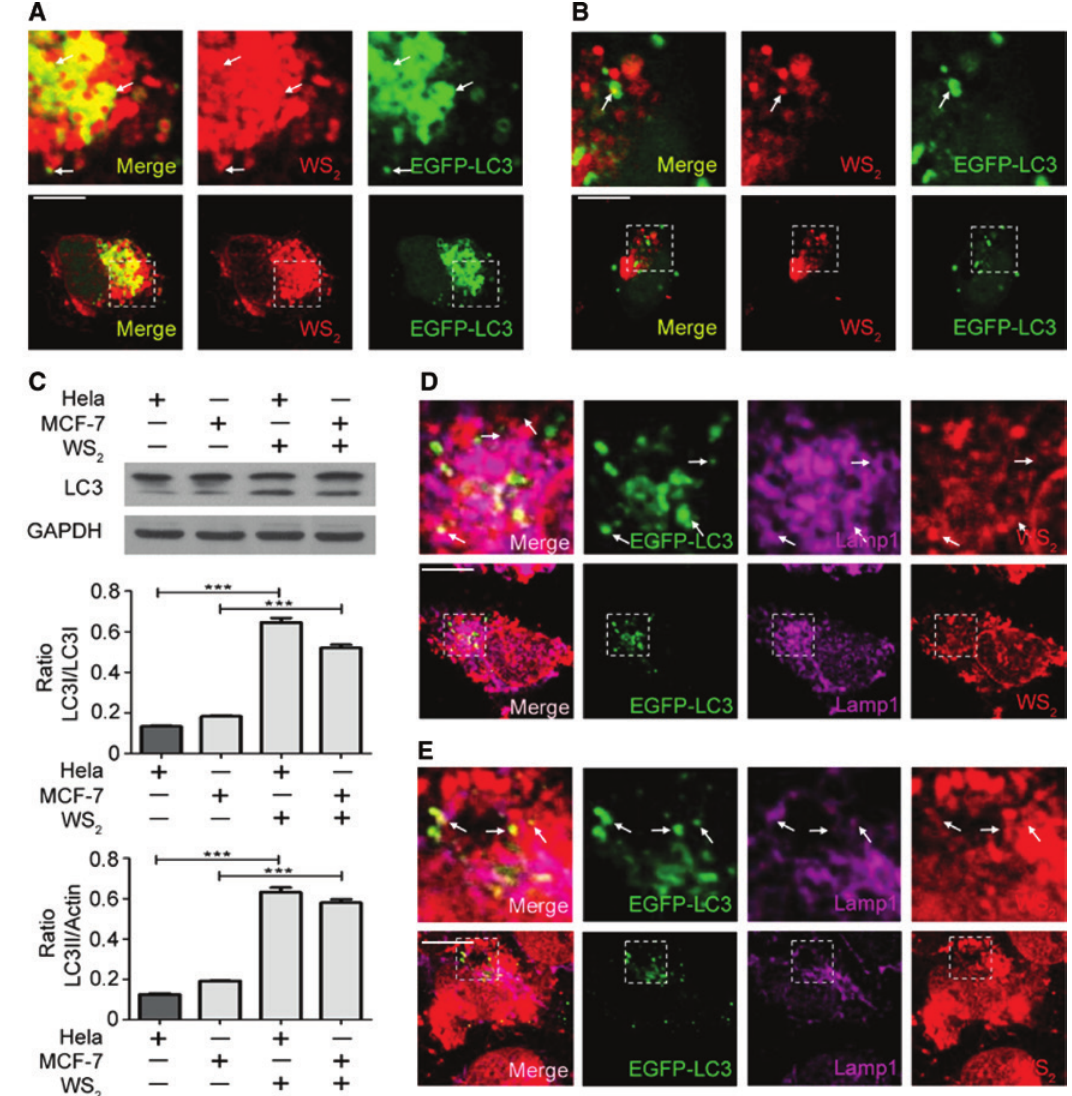
NS accumulation in the lysosome. The co-localization was determined by CLSM images (scale bar, 2